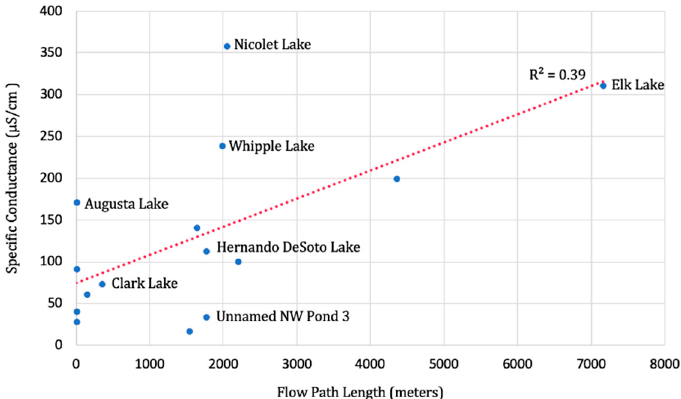
Figure 10. Scatterplot of groundwater flow path lengths and specific conductance measurements for sampled lakes and wetlands. Dotted red line shows the linear regression of the data.